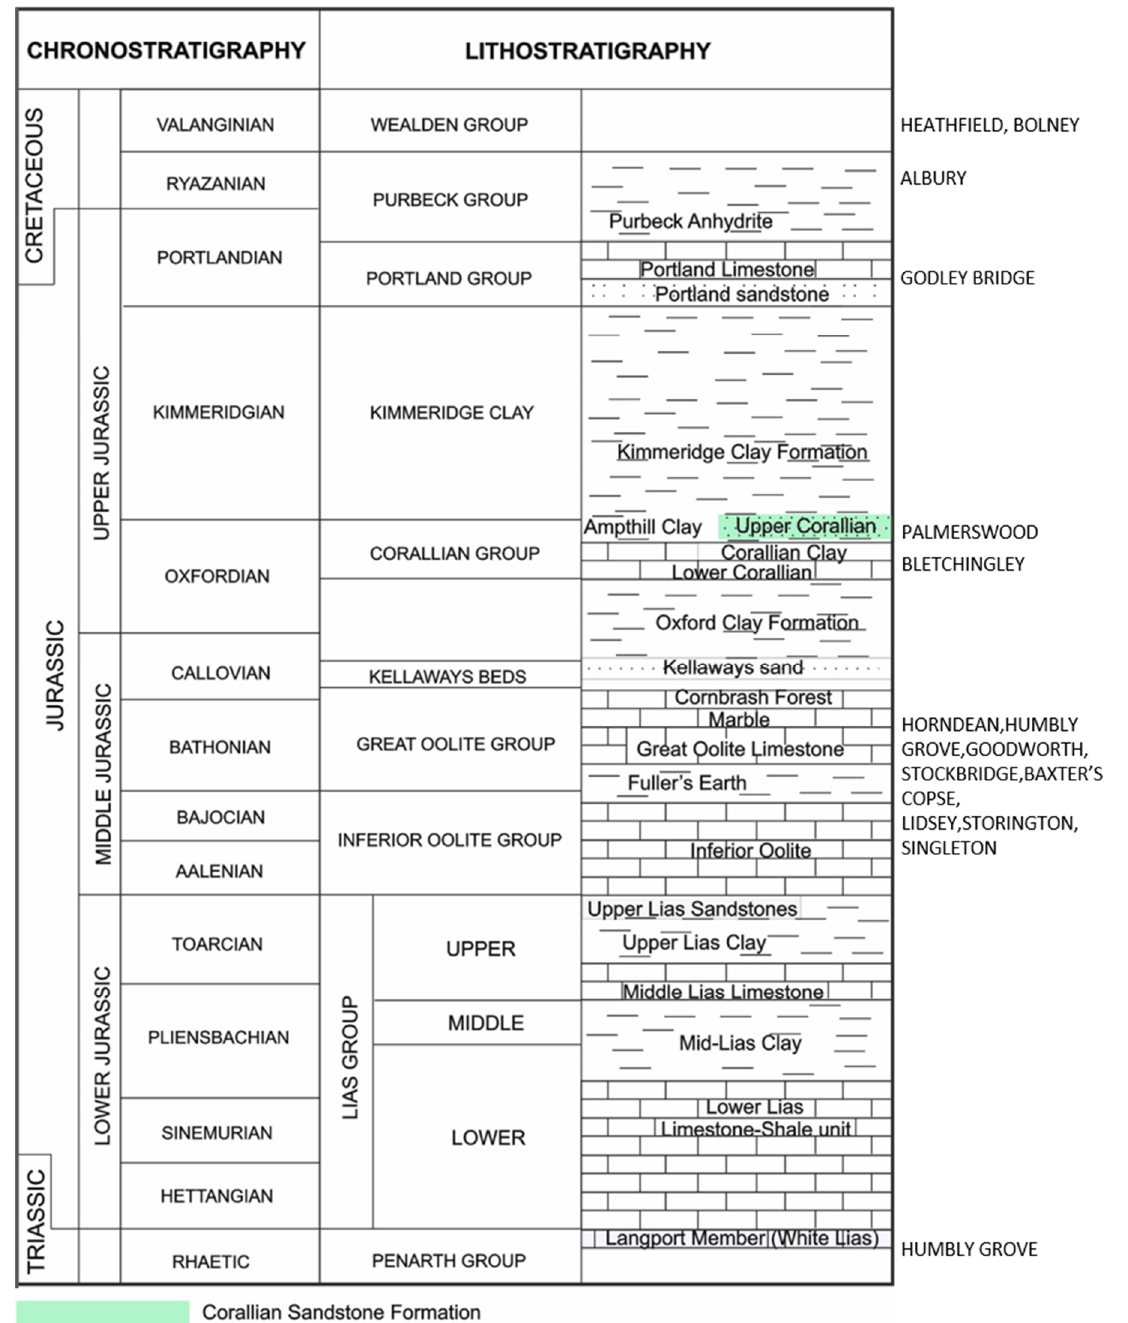
Figure 2. Generalised stratigraphic section for the Jurassic of the Weald Basin as adapted from [7]. Showing lithologic units as well as selected hydrocarbon fields and their reservoir sections. The Corallian sandstone Formation is highlighted in green.